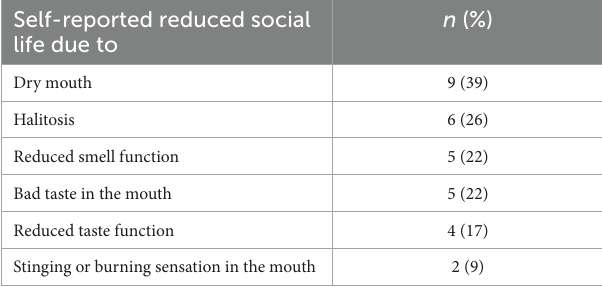
TABLE 10 Number (percentage) of patients self-reporting reduced social life due to oral disorders. Self-reported reduced social life due to